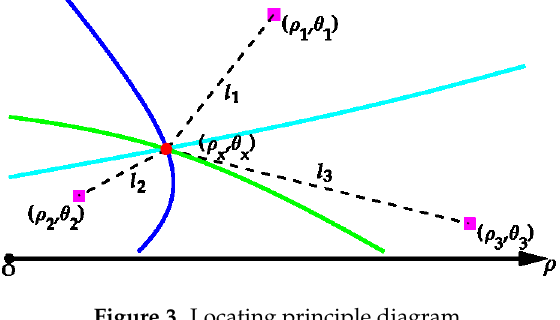
Figure 3. Locating principle diagram.